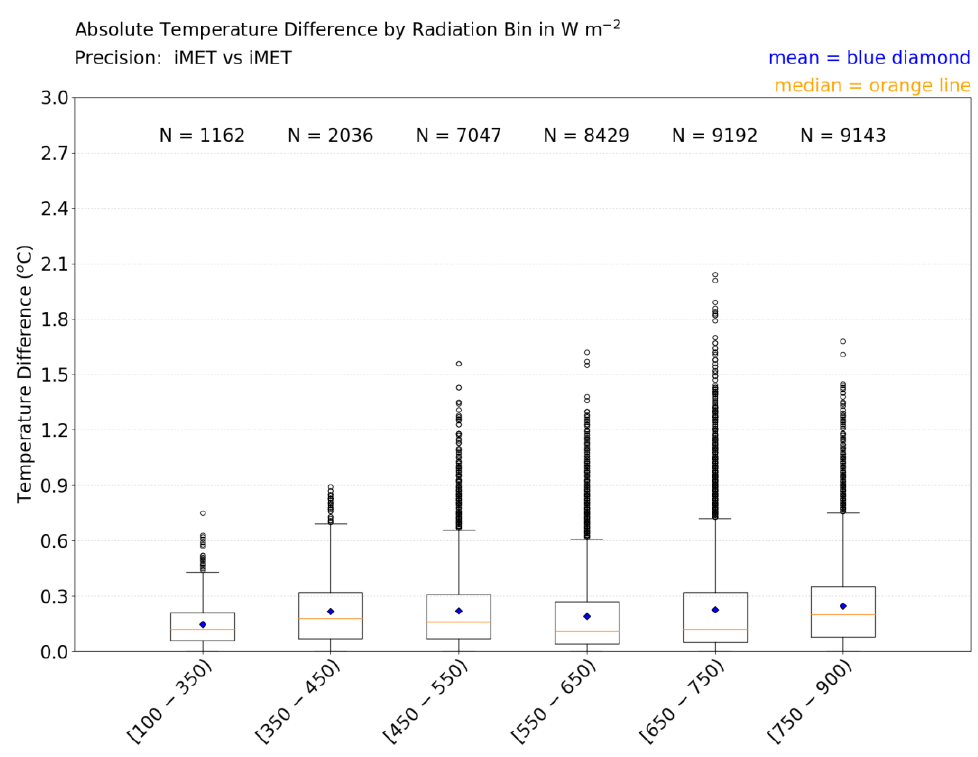
Figure 9. Absolute Temperature Di ff erence of iMET-XQ pairs by solar radiation bin. Sample size (N) for each bin is given above each boxplot.